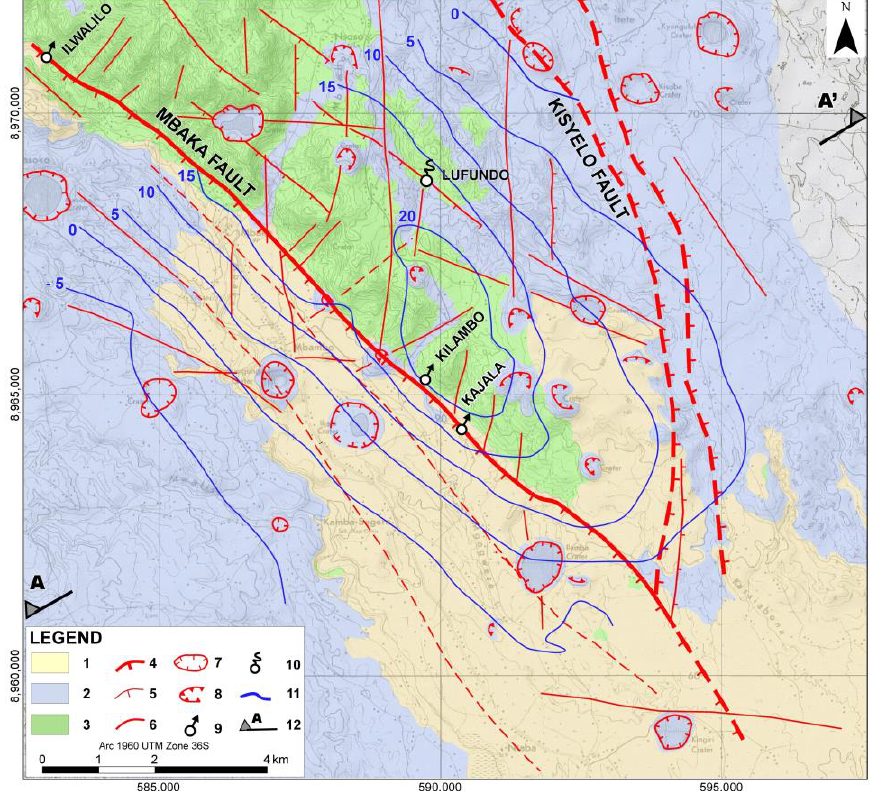
Figure 6. Geological map of the Kilambo-Ilwalilo geothermal play. (1) sediment cover; (2) volcanics; (3) metamorphic basement; (4) major fault (dashed when inferred from geophysical data) with the indication of downthrown side; (5) minor fault (dashed when inferred) with unclear evidence of downthrown side; (6) minor fault (dashed when inferred) with no evidence of downthrown side; (7) Maar crater rim; (8) cinder cone crater rim; (9) hot spring; (10) fumarole; (11) contour lines of the residual Bouguer anomaly (in mGal); (12) cross-section.